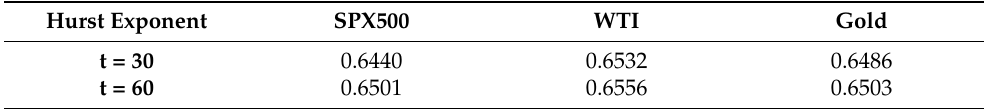
Table 2. Hurst exponent of volatility